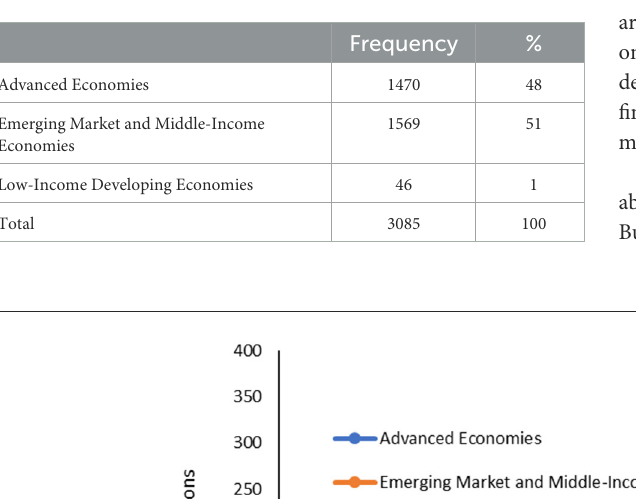
TABLE 4 SSCM Publication output based on IMF classification of countries.